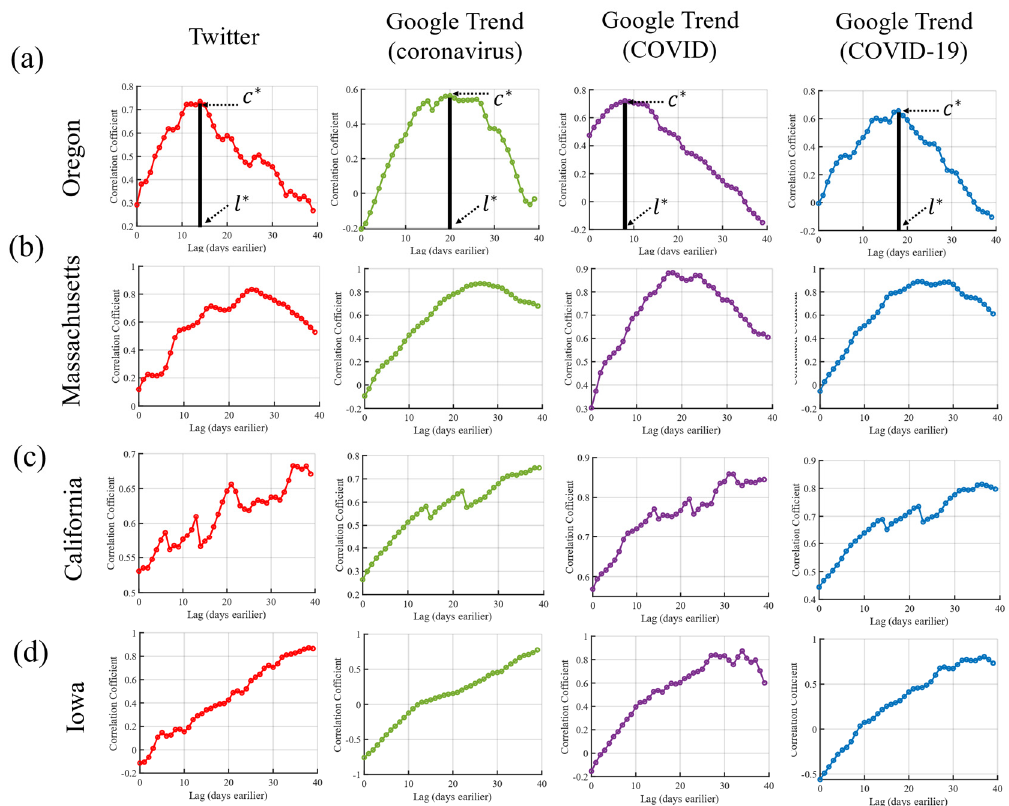
Figure 2. Illustrations of the lagged correlations between new confirmed COVID-19 infections and data from Google Trends and Twitter in the selected 4 states: ( a ) Oregon, ( b ) Massachusetts, ( c ) California ( d ) Iowa.